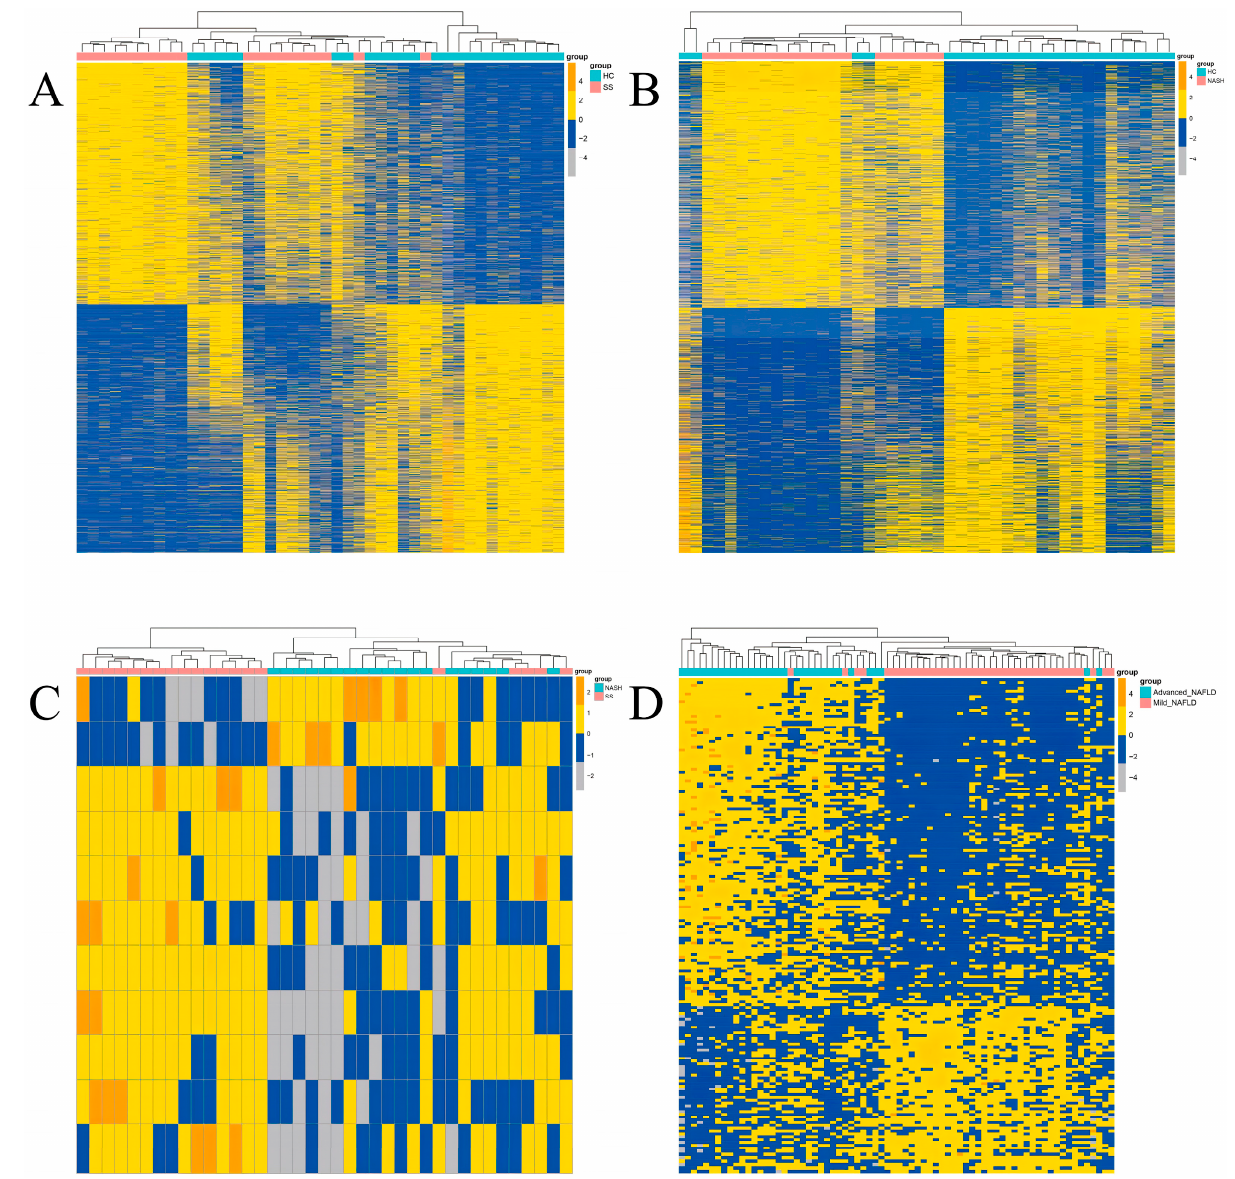
Figure 1. Heatmaps of the DEGs for both databases. ( A ) Comparison of SS and HC in the GSE89632 database. ( B ) Comparison of NASH and HC in the GSE89632 database. ( C ) Comparison of NASH and SS in the GSE89632 database. ( D ) Advanced NAFLD compared to mild NAFLD in the GSE49541 database. Abbreviations: DEGs, differentially expressed genes; SS, simple steatosis; HC, healthy control; NASH, nonalcoholic steatohepatitis; NAFLD, nonalcoholic fatty liver disease.